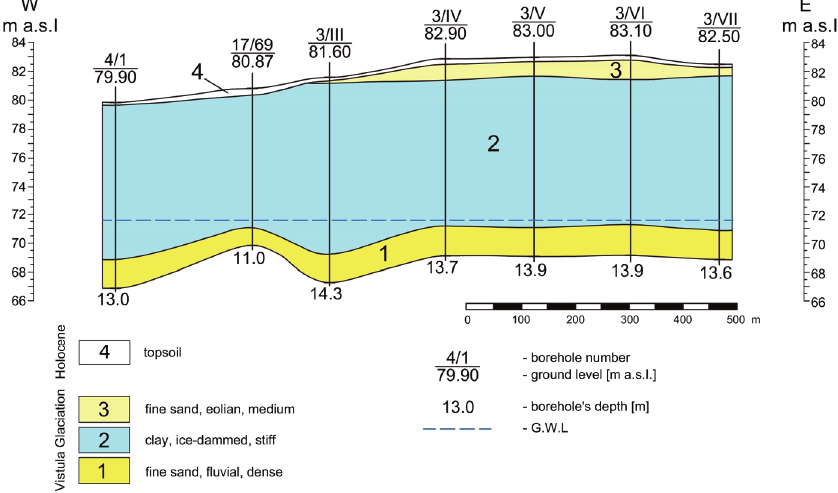
Fig. 3. Geological cross-section